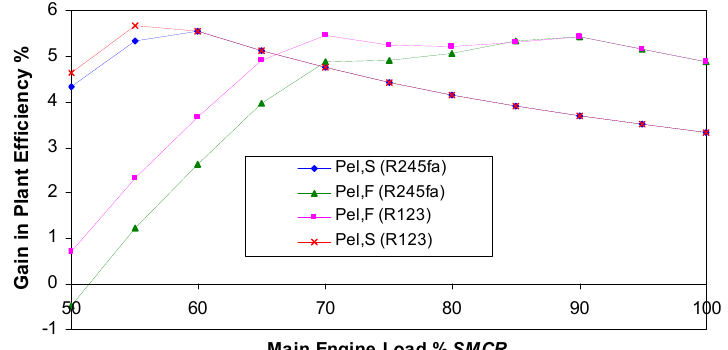
Figure 21. Gain in Ship Power Plant Efficiency with organic fluids—electrical power